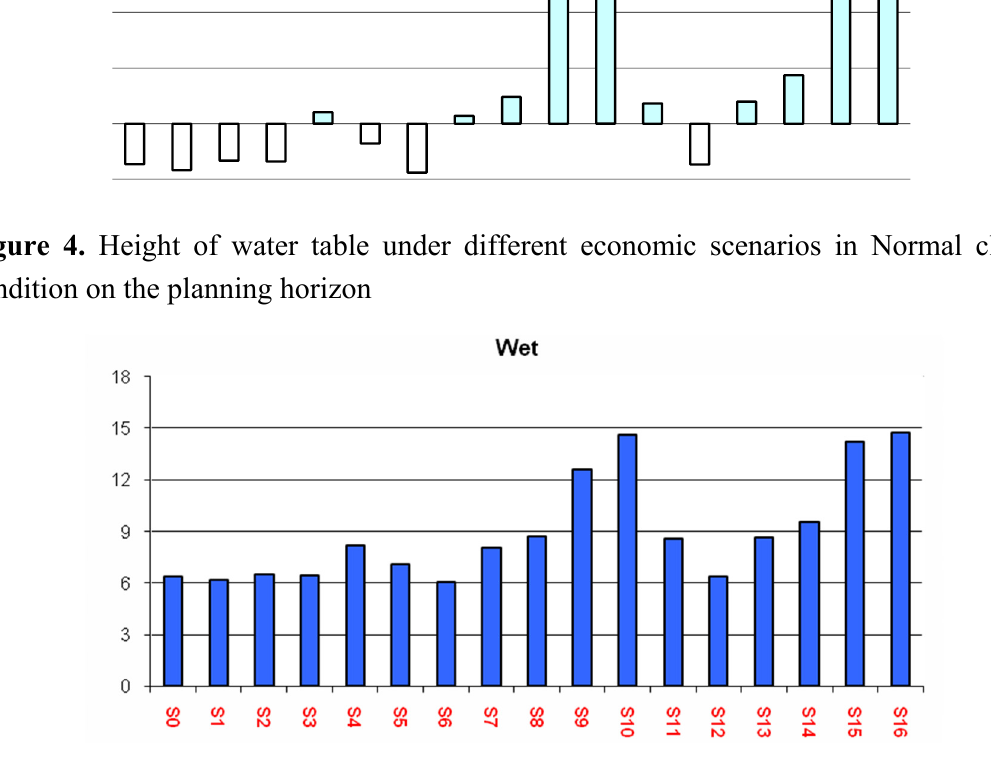
Figure 5. Height of water table under different economic scenarios in Wet climate conditions on the planning